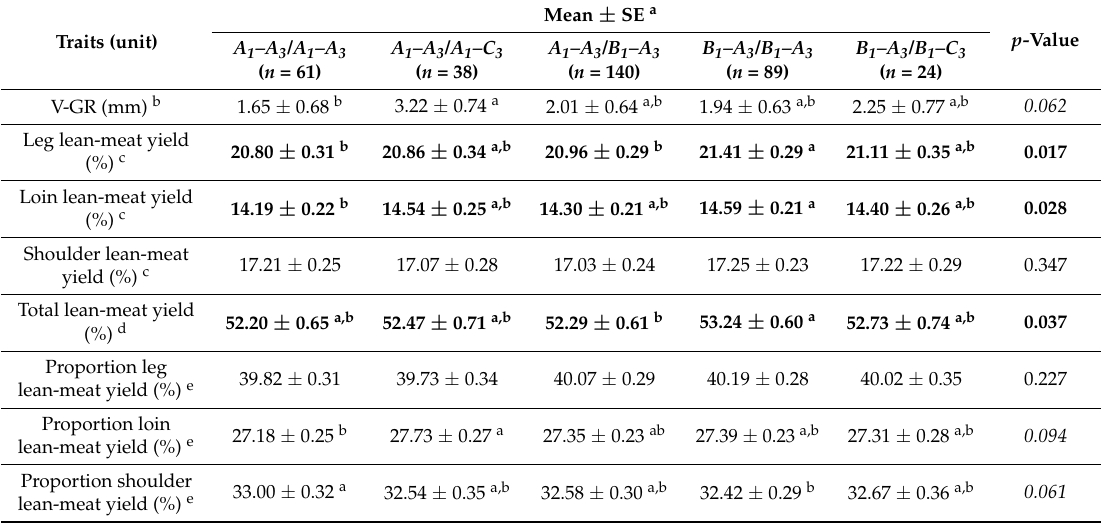
Table 3. Association of ovine ADIPOQ diplotypes with various carcass traits in NZ Romney sheep.